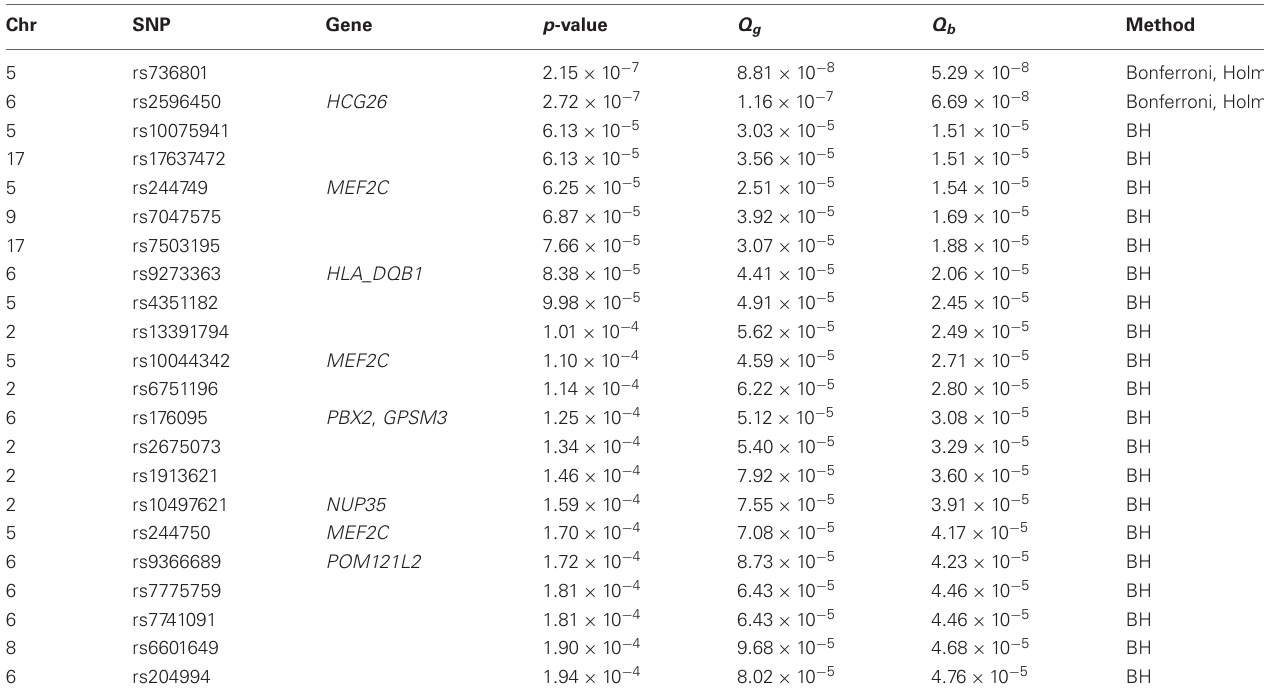
Table 3 | Additional significant SNPs or positive results identified by eQTL weighting methods after accounting for linkage disequilibrium in the GABRIEL analysis.